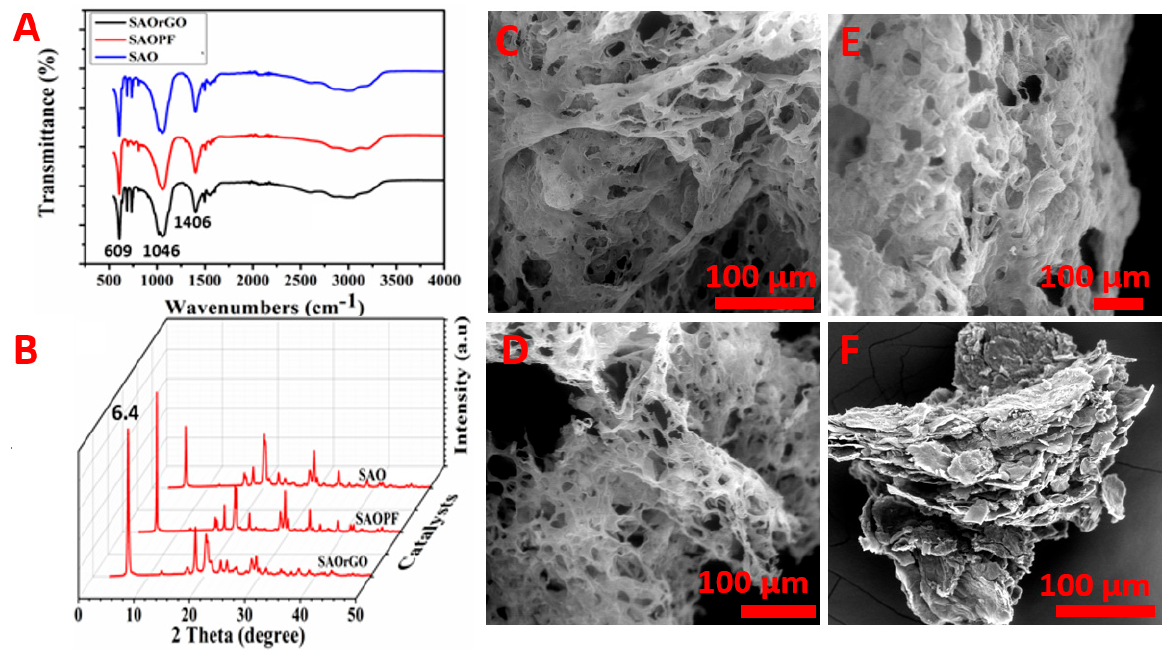
Figure 2. FTIR spectra of ( A ) SAO, SAOrGO and SAOPF; ( B ) XRD diffractograms of SAO, SAOrGO and SAOPF. SEM images of macroporous nitrogen doping catalysts: ( C ) N-SAO, ( D ) N-SAOrGO, ( E ) N-SAOPF and ( F ) N-rGOPF.